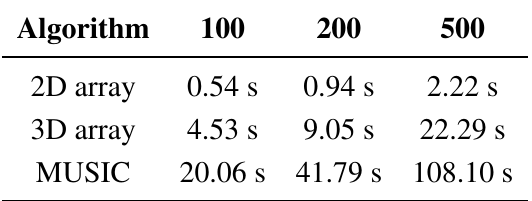
Table 1. The consuming time of three